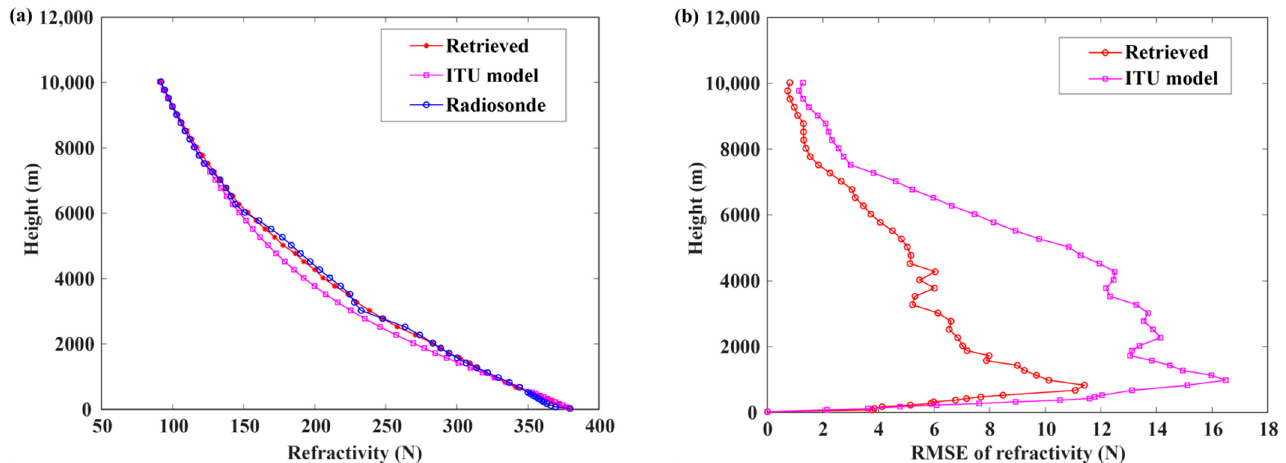
Figure 9. ( a ) The comparison between fitted, ITU model, and radiosonde refractivity profile; ( b ) The root mean square error of fitted and ITU model refractivity profile.